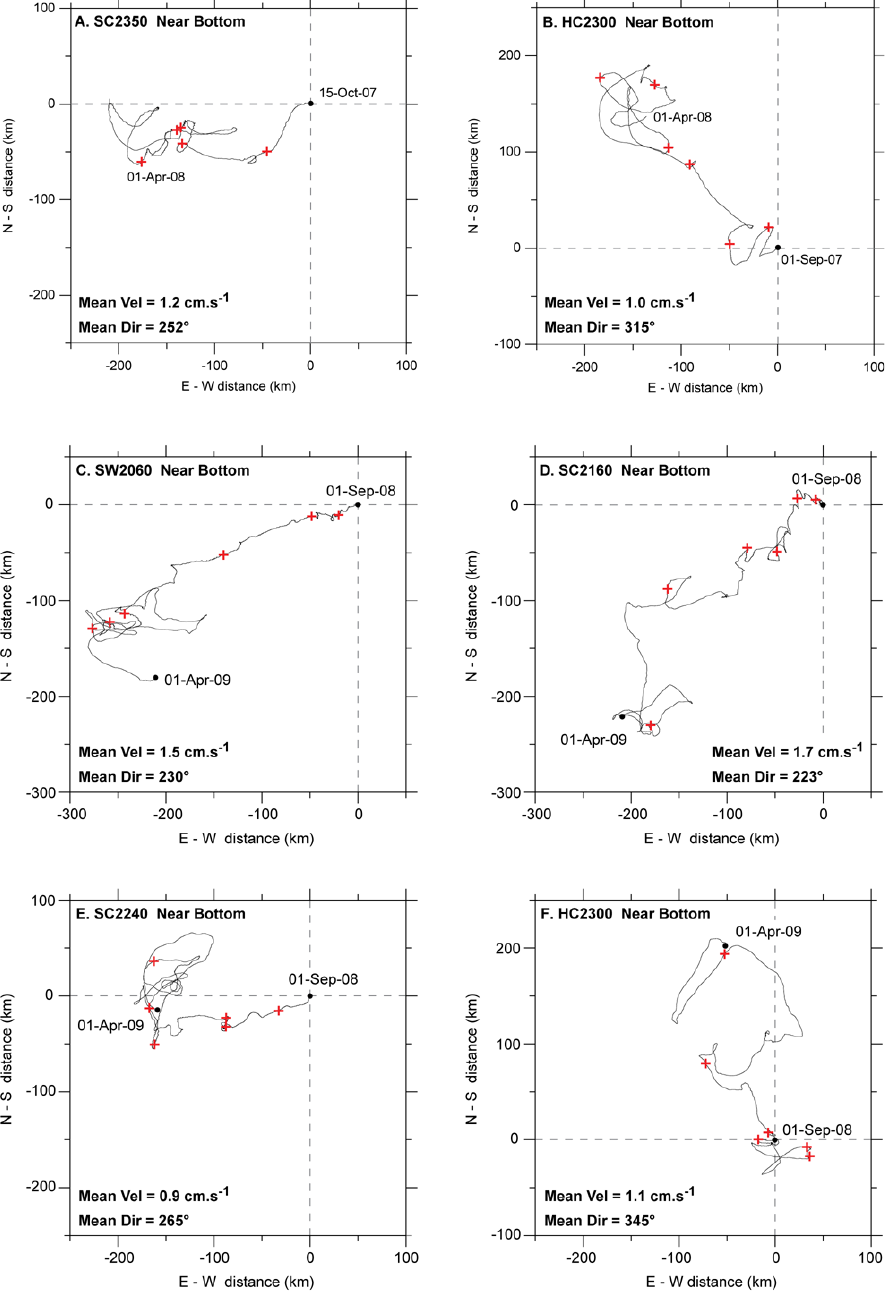
Fig. 7. Progressive vector diagrams of the near-bottom currents from September 2007 to April 2008 at SC2350 (A) and HC2300 (B) , and from September 2008 to April 2009 at SW2060 (C) , SC2160 (D) , SC2240 (E) , and HC2300 (F) . Mean velocity and direction of the currents for the selected periods are indicated. Crosses represent time periods of one